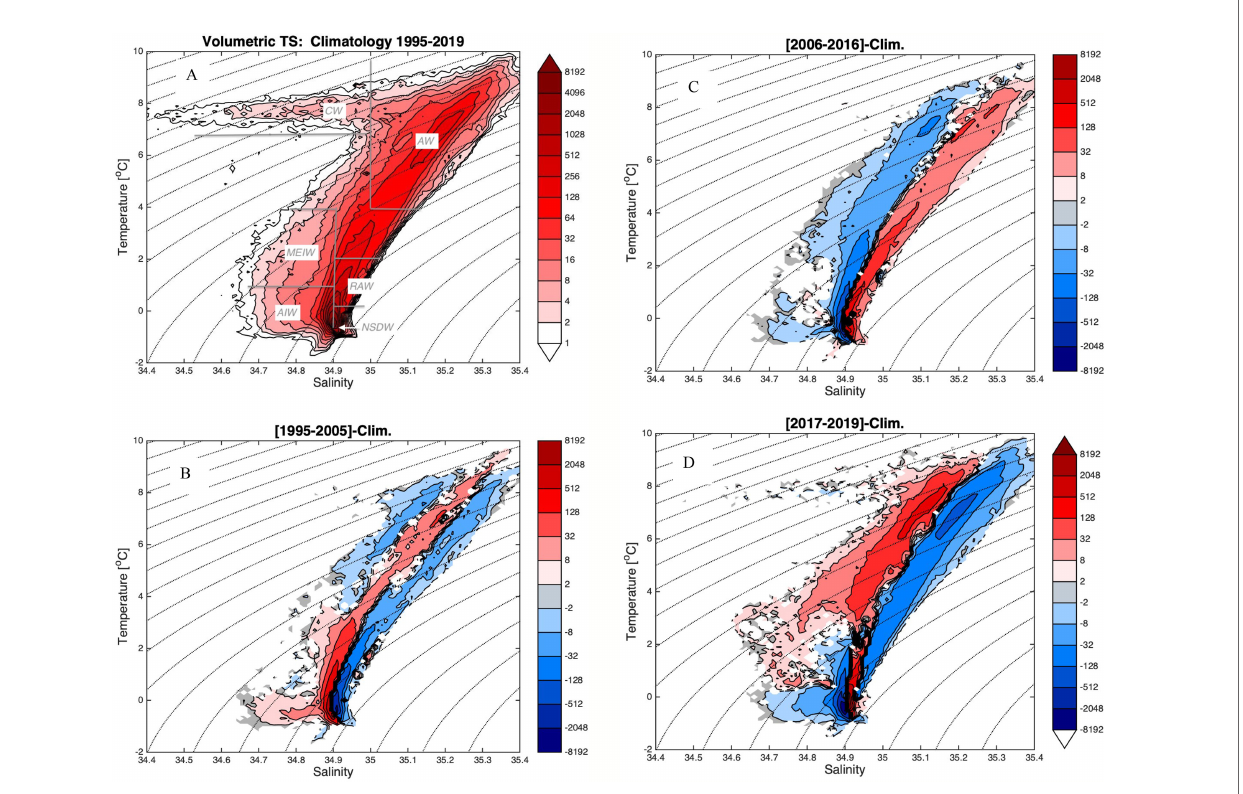
FIGURE 6 | (A – D ) Volumetric TS-plots for the Norwegian Basin. (A) Climatology 1995-2019 including schematic distribution of water masses discussed, (B) difference mean 1995-2005 and the climatology, (C) difference mean 2006-2016 and climatology, and (D) difference mean 2017-2019 and climatology. The values represent number of grid points 0.5° longitude x 0.25° latitude over 5 m depth. The color scale is log 2. In difference plots b-d red colors are positive and blue colors are negative. Data include the depth layers 0-1000m and the area is limited by 62 and 69°N and 12°W and 8°E (see area Figure 1 ). Dashed lines are isopycnal lines. Abbreviations for water masses includes Atlantic Water (AW), Return Atlantic Water (RAW), Artic Intermediate Water (AIW), Modi fi ed East Icelandic Water (MEIW), Norwegian Sea Deep Water (NSDW) and Coastal Water